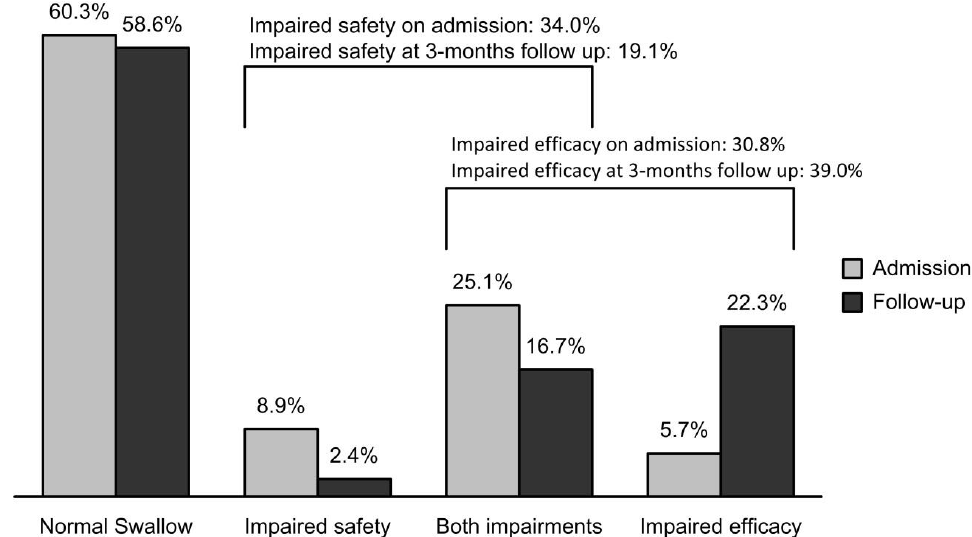
Figure 2. Description of development of clinical signs of oropharyngeal dysphagia on admission and at the 3-month follow up.